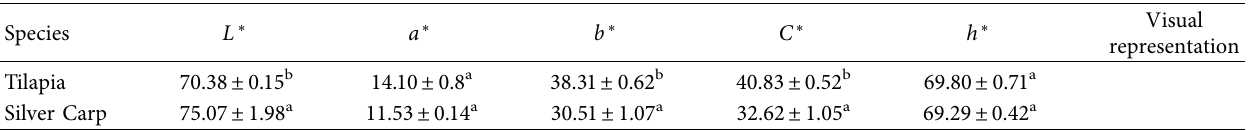
Table 3: Colourimetric values for Silver Carp and Tilapia fsh